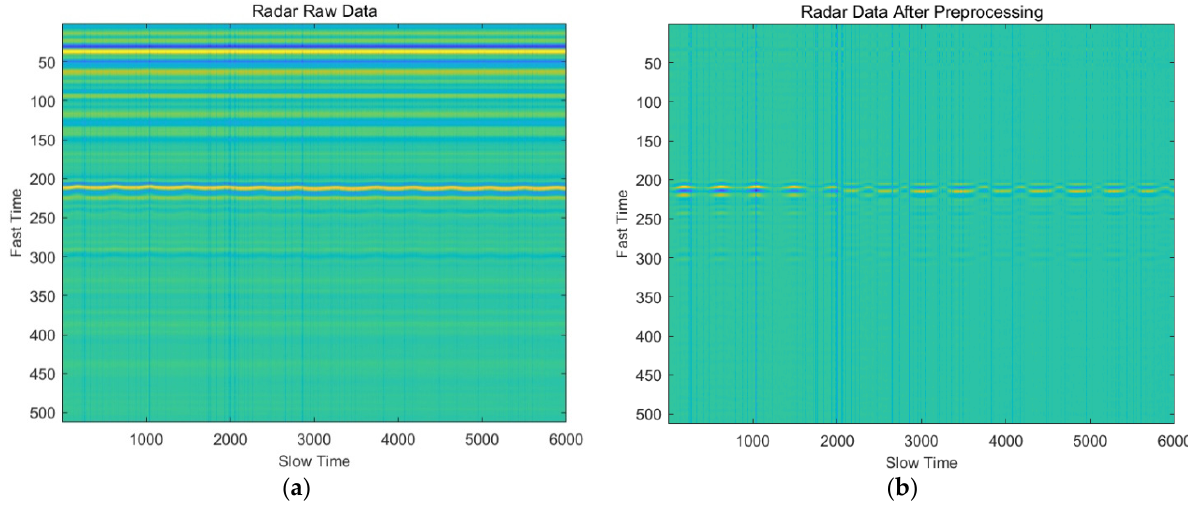
Figure 5. Signal preprocessing performance: ( a ) Radar raw data; ( b ) Radar data after preprocessing.